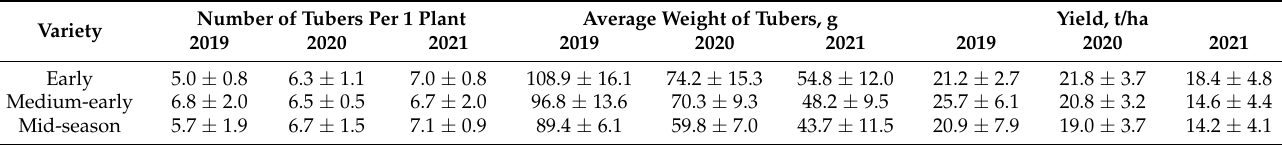
Table 1. Characteristics of variety samples by yield components.